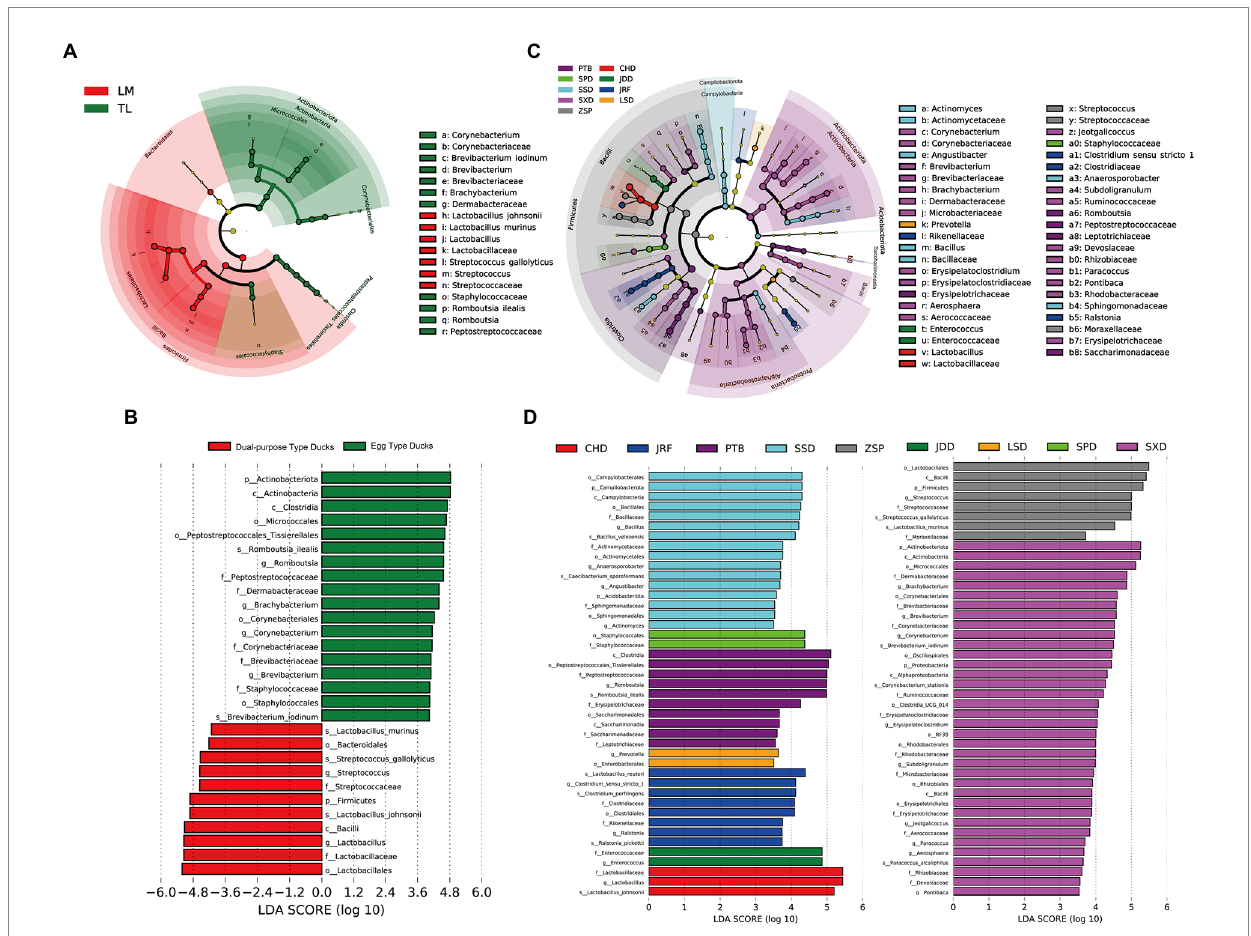
FIGURE 6 The biomarkers in Chinese ducks’ gut microbiota determined by LEfSe among two groups and nine breeds. The gut microbiota of (A) two groups and (C) nine breeds were compared. Colors indicate taxa or branches of the tree, which represent more significant groups. The size of each node represents their relative abundance. The gut microbiota of two groups (B) and nine breeds (D) were compared and determined as biomarkers using Kruskal-Wallis test ( p < 0.05) with LDA score > 4 ( B ) and 3.5 ( D